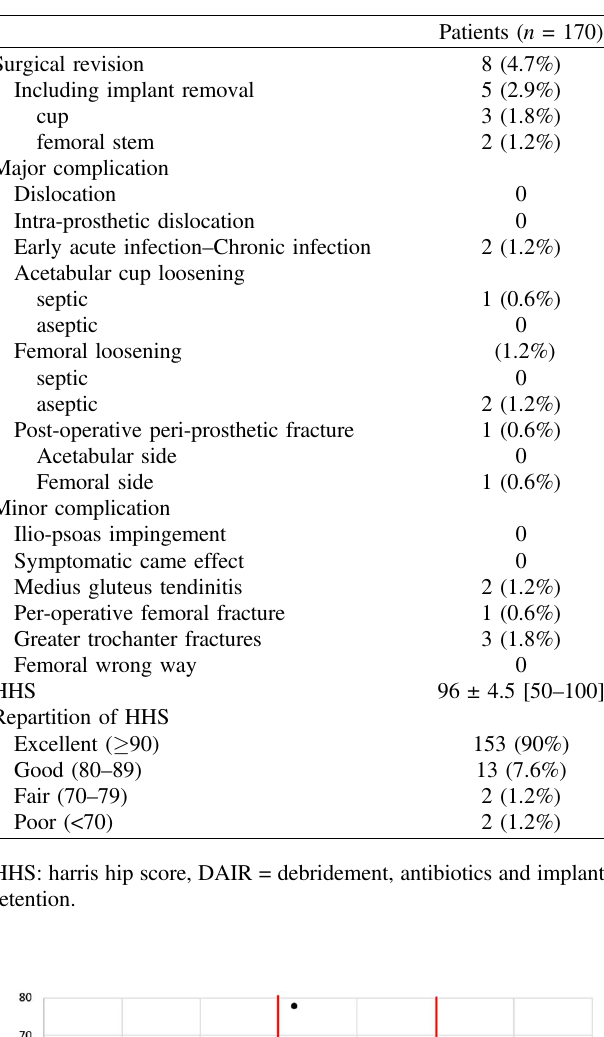
Table 2. Intra and postoperative complications, and postoperative functional outcomes at the last follow-up.